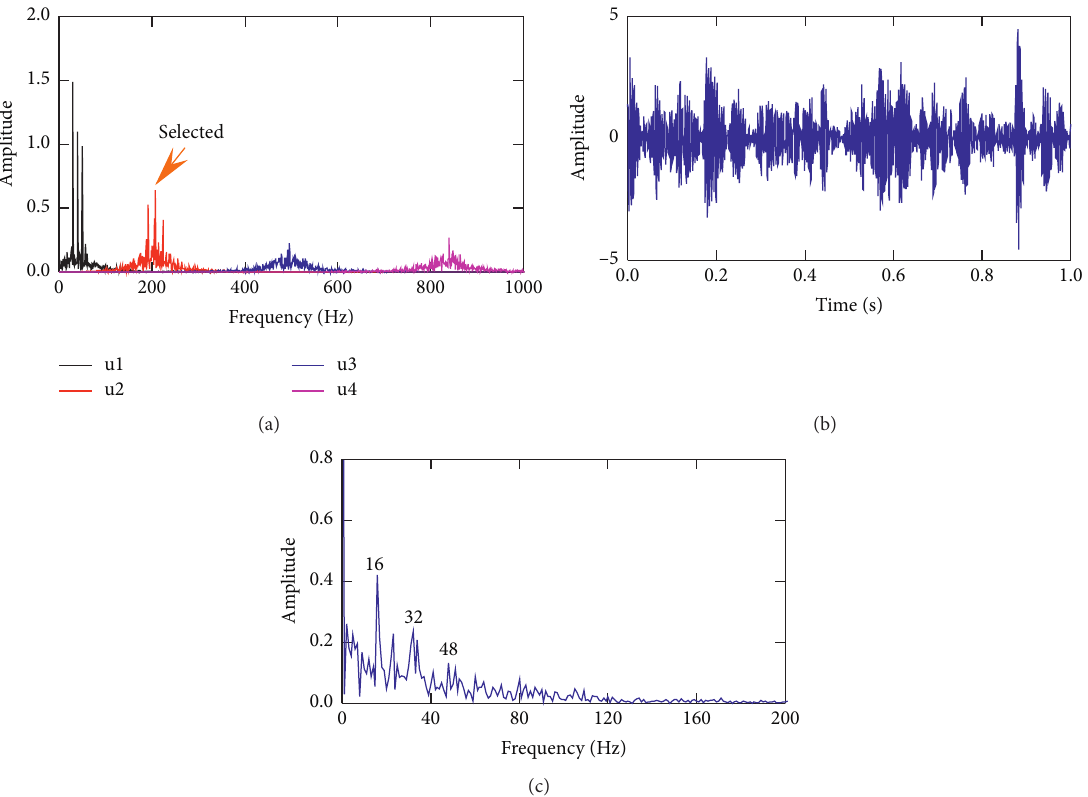
Figure 15: Analysis results of simulation signals by the VMD method with k � 4 and α � 2000: (a) frequency spectrum of the four decomposed modes; (b) time-domain spectrum of mode u2; (c) envelope spectrum of mode